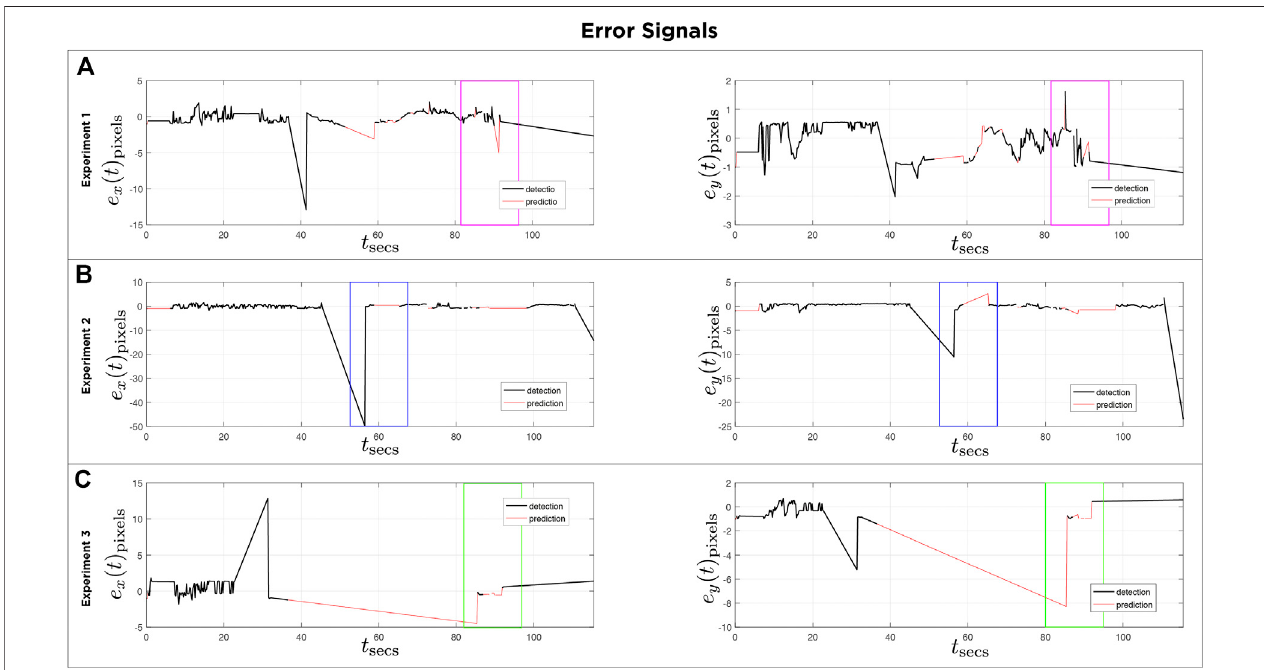
FIGURE 14 | For each of the three experiments (A , B , C) : Error plots signals e ( x ) and e ( y ) used for control law in three experiments. Black lines indicate time intervals when target was detected. Red lines indicate time intervals when controller used the Kalman fi lter prediction.